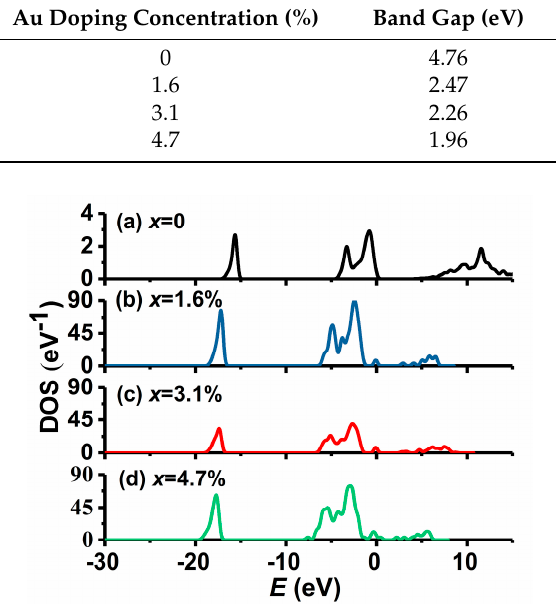
Figure 5. Total densities of electronic states (DOS) of ( a ) an undoped MgO film sample and three Au-doped MgO film samples with x of ( b ) 1.6%, ( c ) 3.1%, and ( d ) 4.7%.